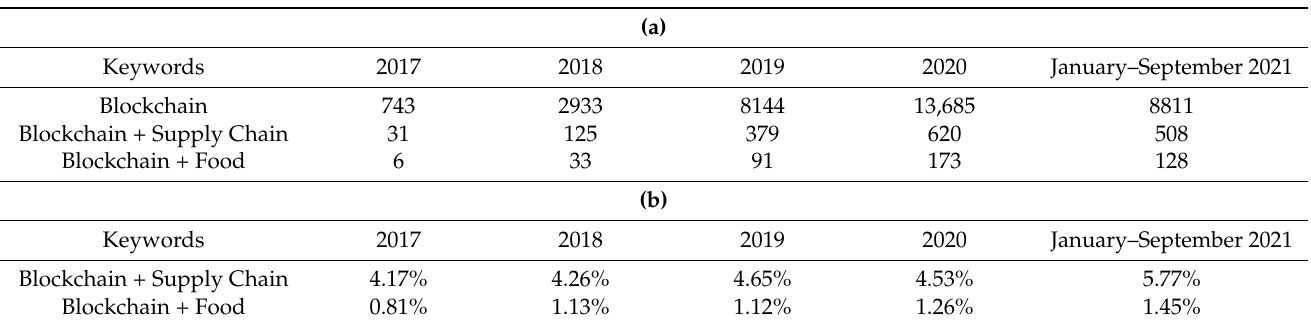
Table 1. ( a ) Absolute numbers of recent publications regarding blockchain and relevant applications, ( b ) percentages of recent publications about blockchain computing related to food or supply chains (based on keyword